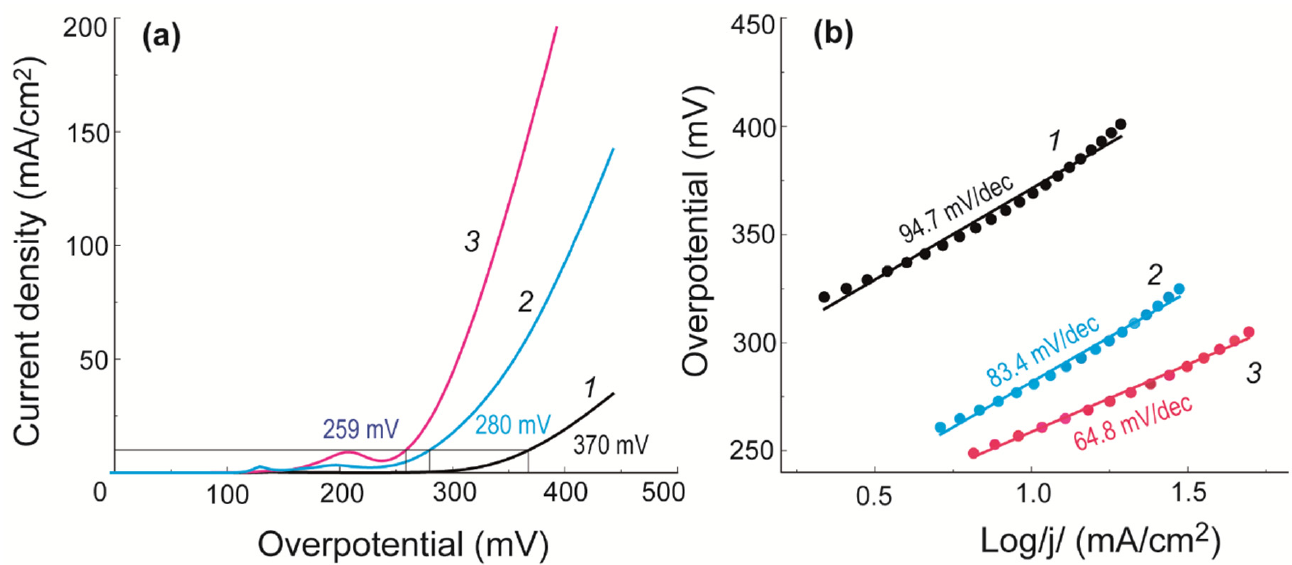
Figure 5. OER polarization curves ( a ) and Tafel plots ( b ) of the nickel electrodes. 1 —nickel foil, 2 —the layer of NiFe 0.3 (OH) x nanoparticles on the nickel foil surface obtained by the drop-casting method, 3 —NiFe 0.3 (OH) x VLM on the surface of nickel foil.